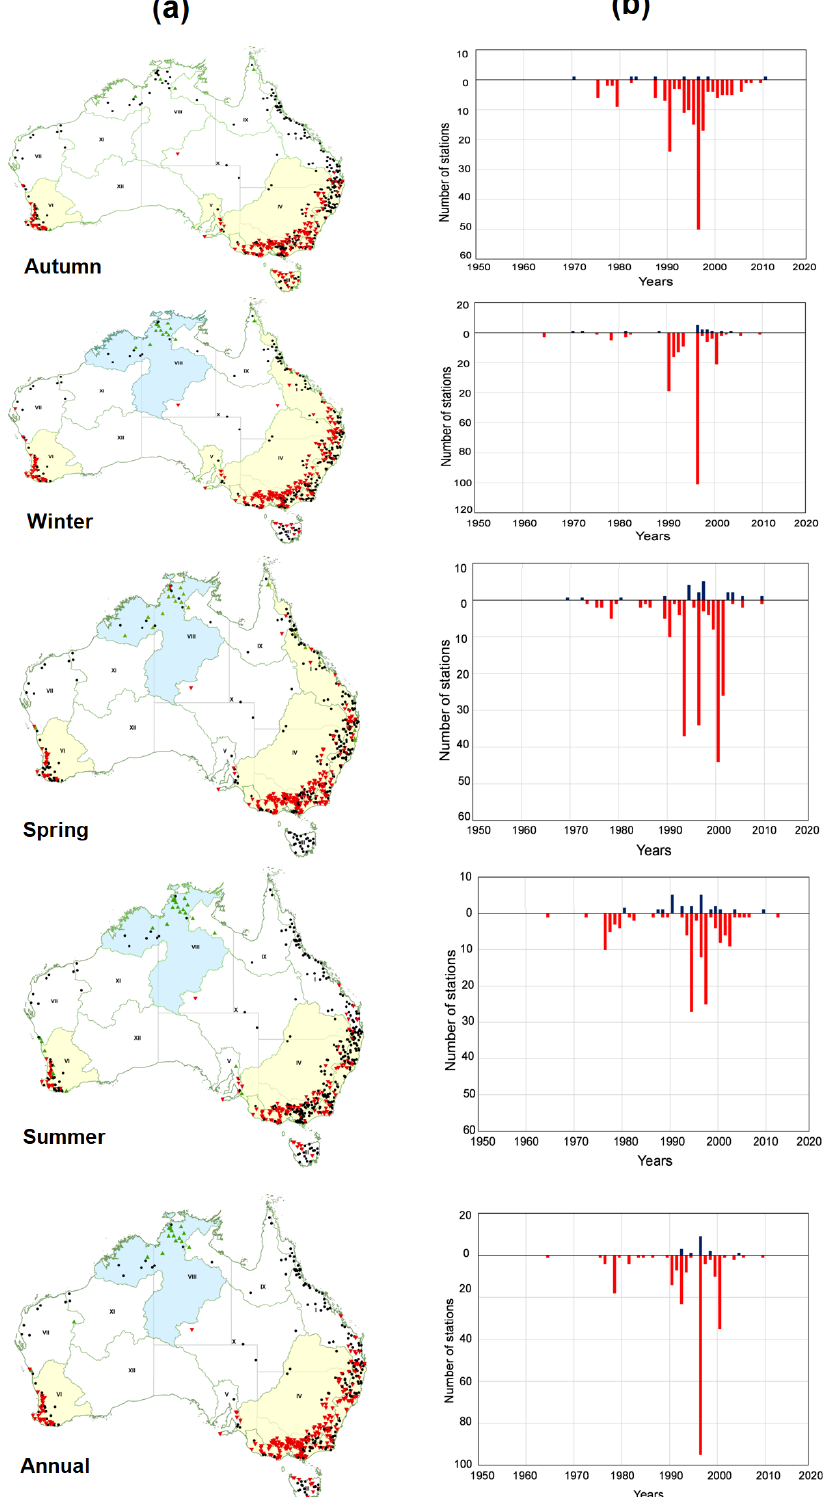
Figure 9. (a) Map showing stations with step changes in flow across each season and water year (at a significance level of p < 0 . 1). Upward- pointing green triangles and downward-pointing red triangles represent upward and downward step changes respectively, whereas black dots refer to sites without significant shifts. Drainage divisions with positive and negative shifts with regional significance at p < 0 . 1 are coloured blue and yellow respectively. (b) The number of stations with significant step changes in flows ( p < 0 . 1) across each season and water